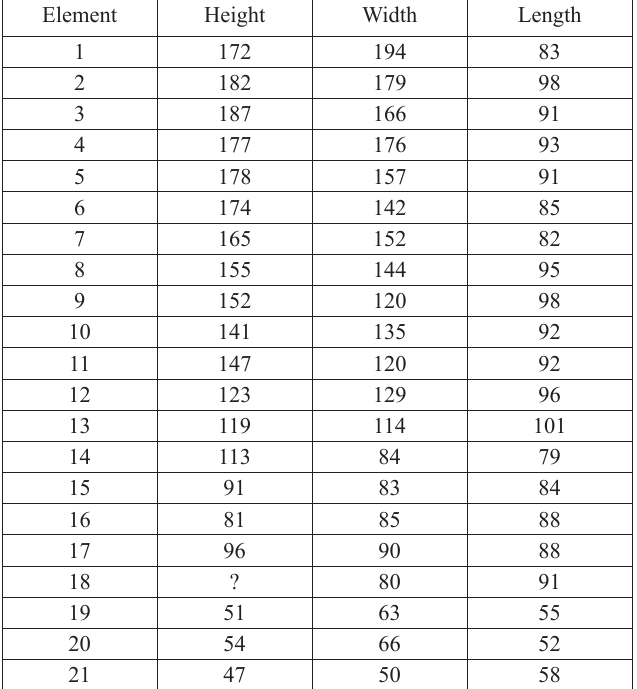
Table 1. Measurements (in mm) of the caudal vertebrae centra of Lam- beosaurinae indet. FCBUANL_2711. Element numbers are tentative and do not consider the missing